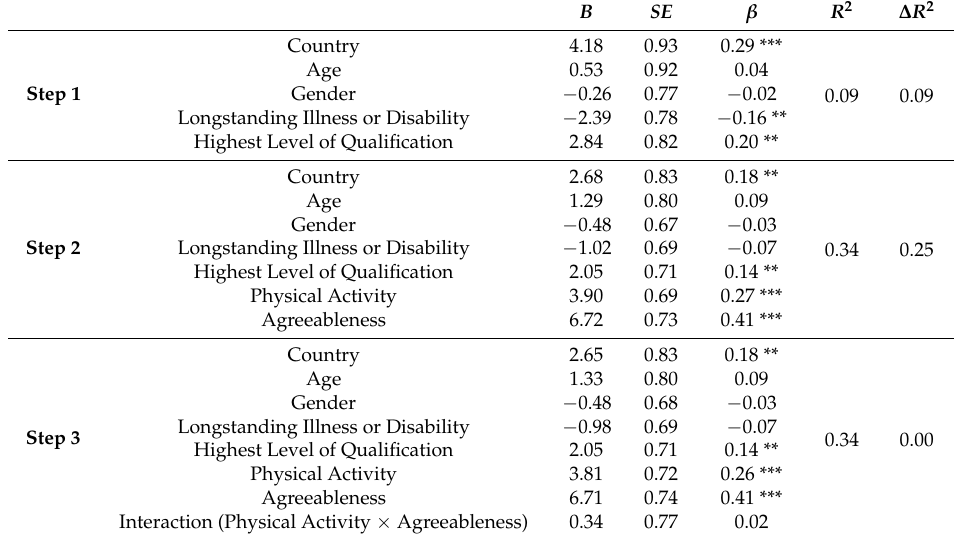
Table 5. Interaction analysis for physical activity and agreeableness.